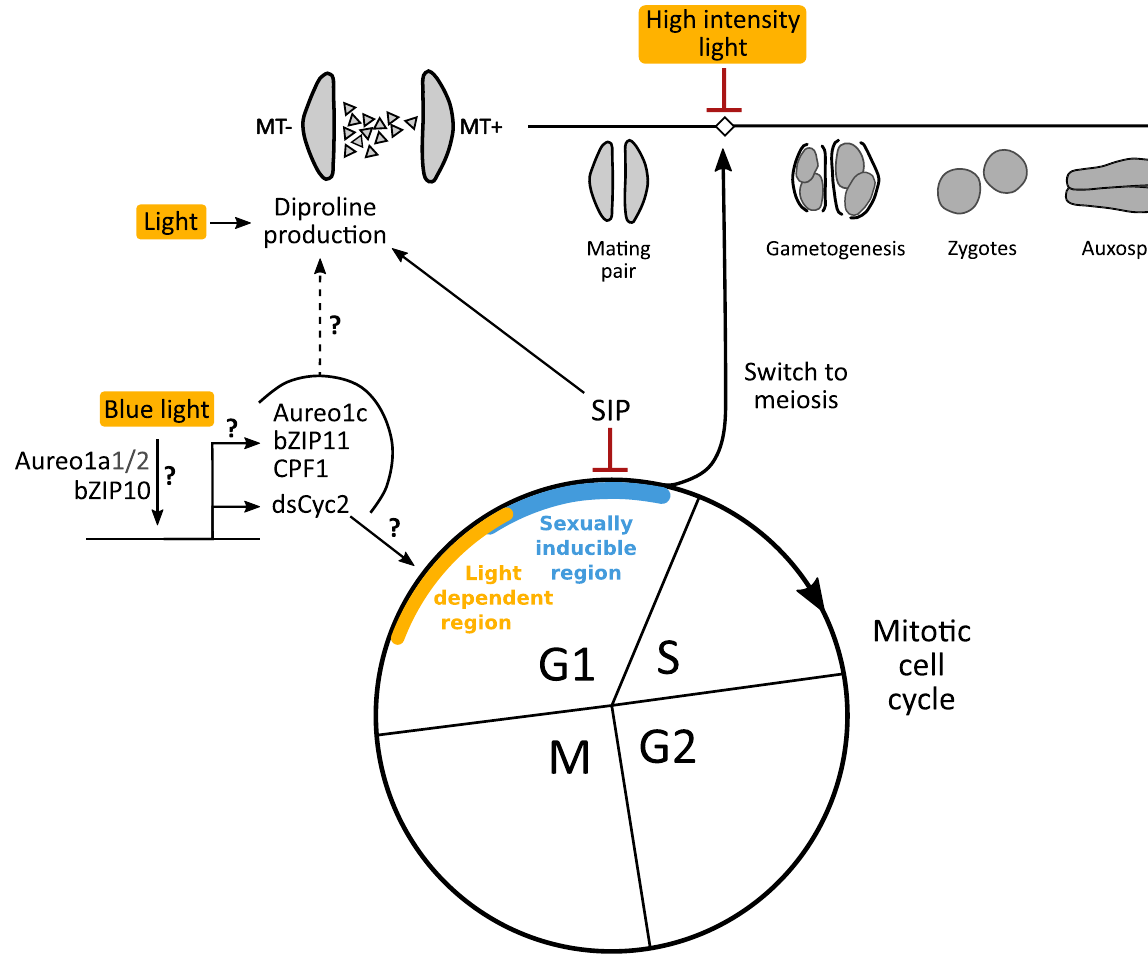
Figure 6. A hypothetical model for the influence of light on the vegetative and sexual life cycle of Seminavis robusta . On top, the different sexual stages of the S. robusta mating process are shown. Below, the mitotic cell cycle is visualized, with positions of the light-dependent checkpoint (yellow) and sexually inducible region (blue) in the G1 phase. Genes presumably involved in the progression of the G1 light-dependent checkpoint under blue light are indicated, with an aureochrome Aureo1a homolog (either Aureo1a1 or Aureo1a2 ) and bZIP10 driving the expression of the diatom-specific cyclin dsCyc2 and other putative downstream genes ( Aureo1c , basic leucine zipper bZIP11 , cryptochrome/photolyase family CPF1 ). A red flat ended line represents inhibition of a particular step, while black arrows indicate induction or progression. SIP = sex inducing pheromone. MT = mating type. Hypothetical steps that require further elucidation are indicated with question marks. The dotted-line arrow shows possible pathways for light-dependent regulation of diproline production via targets of